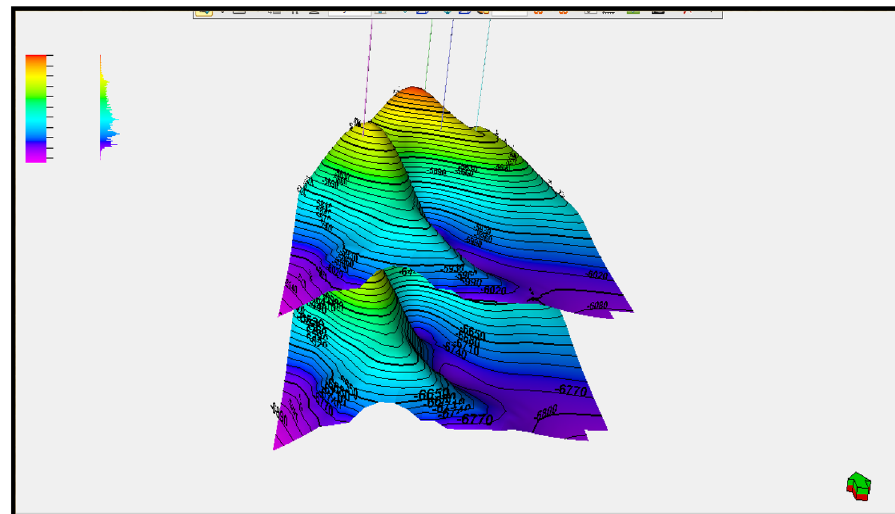
Fig. 1 Top and base of the